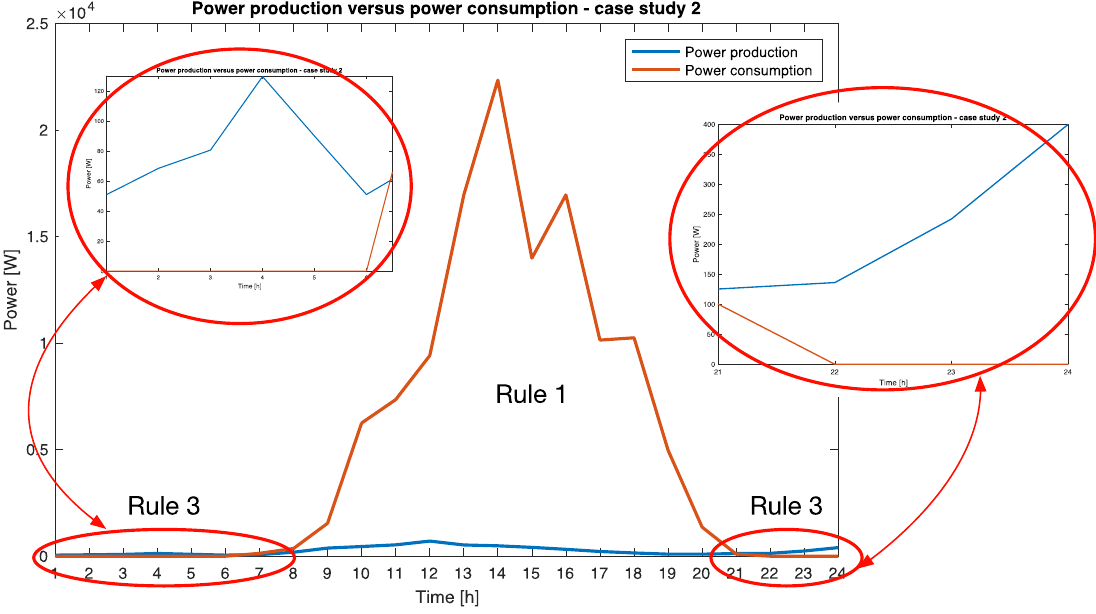
Figure 15. Load–generation curves for the day of 5 May: case study 2.